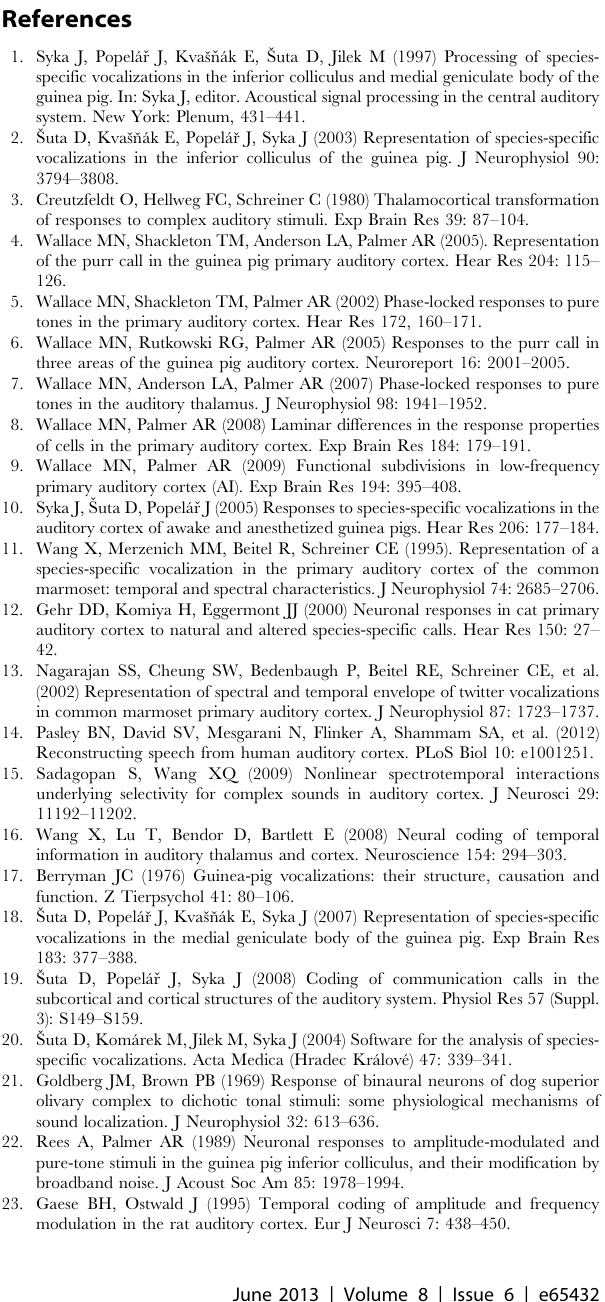
Figure S1 Distribution of the neuronal characteristic frequencies (CFs). Table S1 Parameters of the filter mimicking the guinea-pig audiogram.